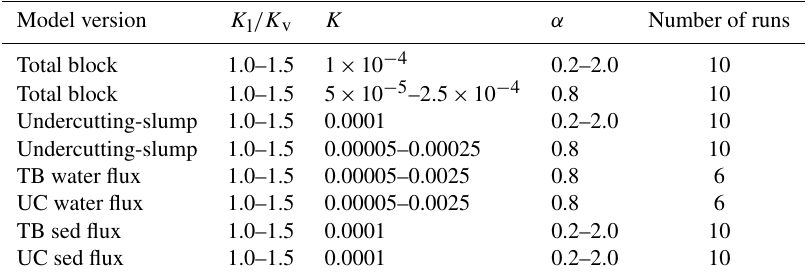
Table 1. Model runs and parameters discussed in this